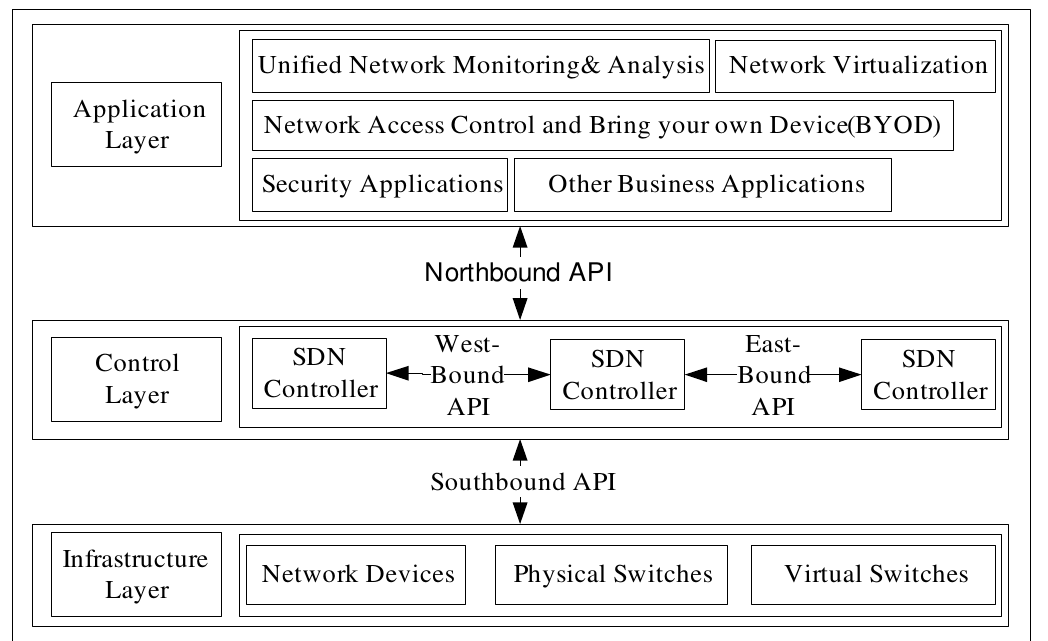
Figure 1. The basic overview of SDN which includes an Application layer, Control Layer and Data